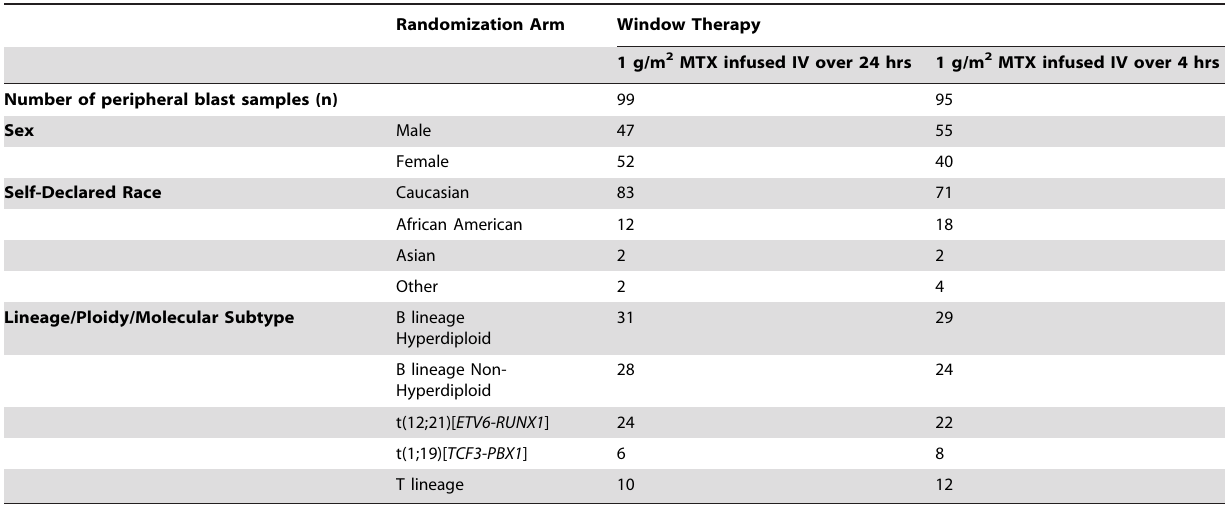
Table 1. Summary statistics of patients in this